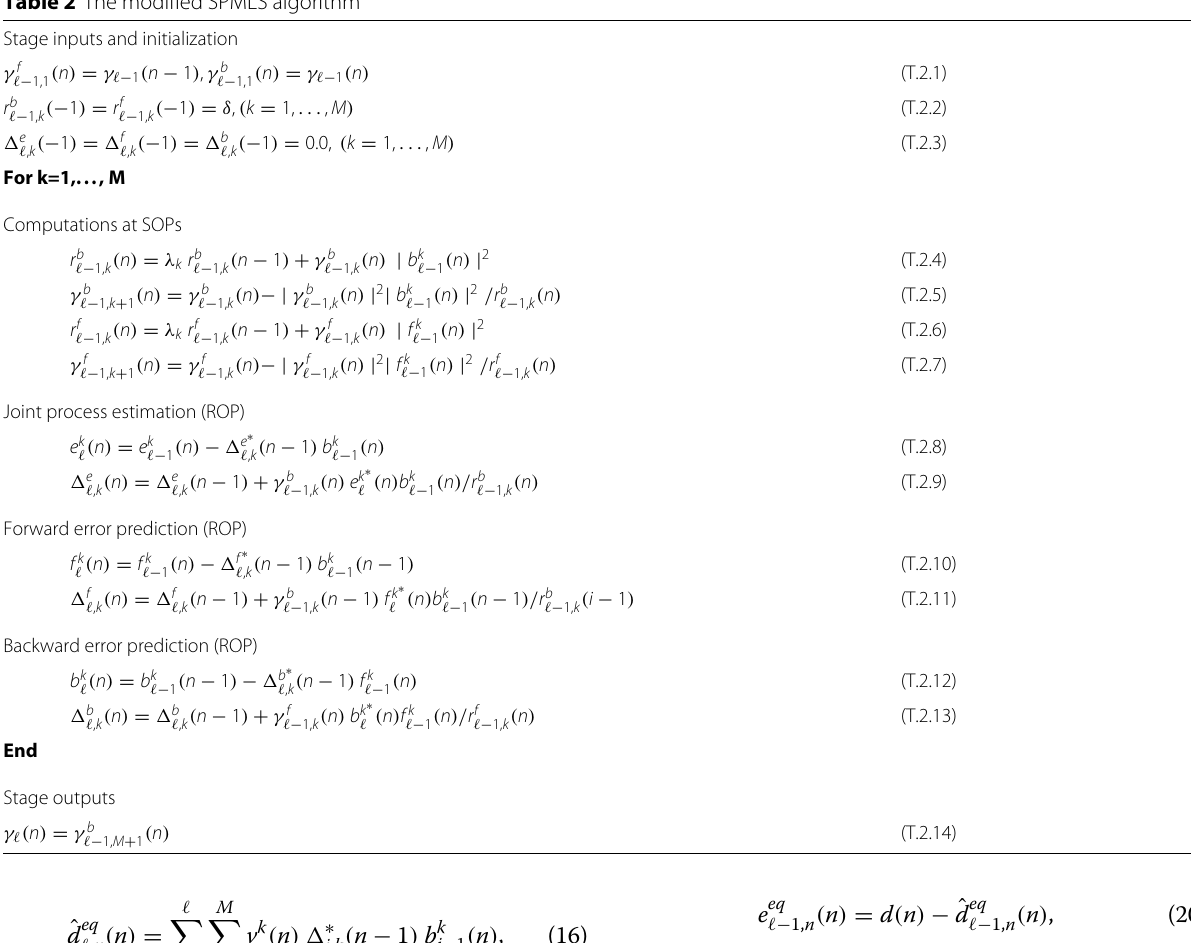
Table 2 The modified SPMLS